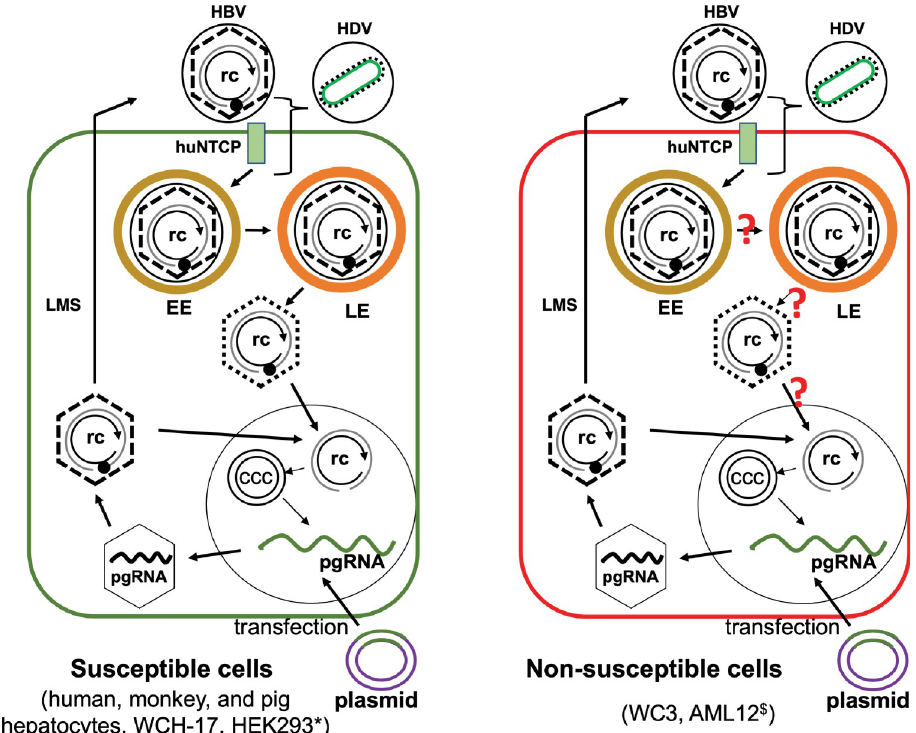
Fig 7. Model of HBV infection in susceptible and non-susceptible cells. WCH-17 and HEK293 (left) and WC3 (right) cells could support HBV cccDNA formation via the intracellular amplification pathway after HBV replicon transfection. Ectopic expression of huNTCP in WCH-17 and HEK293 cells (and other cells, see text) allowed HBV infection as evidenced by the establishment of cccDNA in the nucleus of infected cells. However, huNTCP expression in WC3 cells failed to support HBV infection, indicating an infection block at a step(s) after initial entry steps shared with HDV (in bracket) and prior to the nuclear import of rcDNA, the common step for cccDNA formation shared between infection and intracellular amplification. rc, relaxed circular DNA; ccc, covalently closed circular DNA; EE, early endosome; LE, late endosome; LMS, larger, middle, and small surface proteins. � , HEK293 cells cannot support HBV gene expression due to the lack of liver-specific transcription factors. $ , AML12 cells support efficient HBV cccDNA formation via intracellular amplification but are only weakly susceptible to HBV infection after huNTCP expression.?, potential steps during HBV infection that may be blocked in WC3 cells. See text for